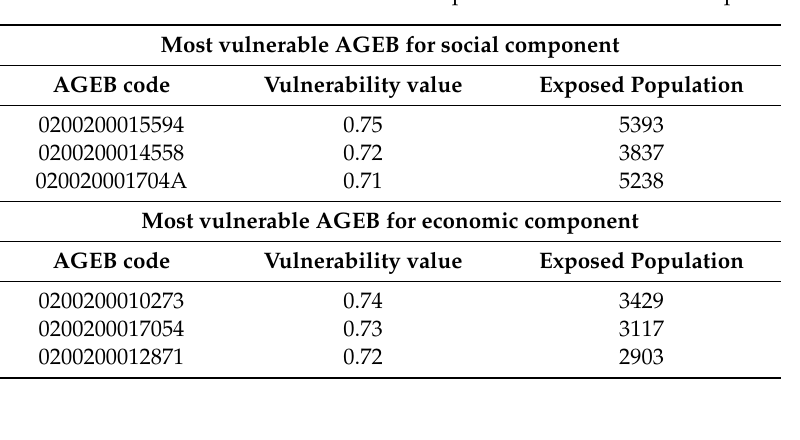
Table 4. Most vulnerable AGEB units for each component and the overall composed FVI